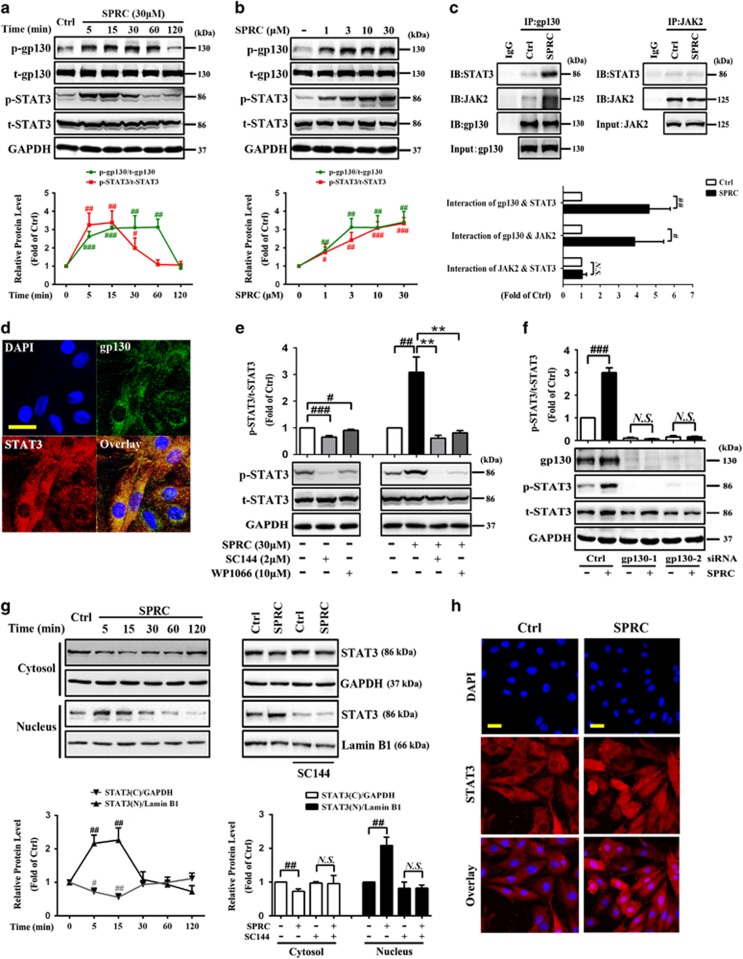
SPRC induces STAT3 phosphorylation and nuclear translocation via gp130 in cardiomyocytes. H9c2 cardiac myocytes were treated either (a) with 30 μM SPRC for the indicated durations or (b) with increasing concentrations of SPRC for 10 min. Cell lysates were collected and subjected to western blot for evaluating phospho-gp130 and phospho-STAT3. (c) H9c2 cells were treated with SPRC (30 μM) for 10 min. Cells lysates were immunoprecipitated with gp130 or JAK2 antibody, and the bound proteins were fractionated on SDS-PAGE gel, then analyzed by western blot with antibodies indicated. (d) Cells were incubated with SPRC (30 μM) for 10 min, and then double-immunostained for gp130 and STAT3 and the nuclei were visualized by DAPI staining. Scale bar, 50 μm. (e) Cells were pretreated with 2 μM SC144 (gp130 inhibitor) or 10 μM WP1066 (STAT3 inhibitor) for 1 h, followed by SPRC stimulation. (f) Cells were incubated with SPRC after gp130 silencing, which was conducted by siRNA transfection for 48 h. (g) Cells were treated with SPRC for the indicated durations, or pretreated with/without SC144 for 1 h before SPRC stimulation for 10 min. Levels of STAT3 in the cytosol and nucleus were analyzed by western blot. GAPDH and Lamin B1 were used as loading control for cytosolic and nuclear proteins, respectively. (h) STAT3 nuclear translocation after 10 min of SPRC treatment was detected by confocal microscopy. Scale bars, 50 μm. Values are presented as mean±S.D. from n=3 replicates. #P<0.05, ##P<0.01, ###P<0.001 compared with the control group; **P<0.01 compared with the SPRC-treated group. NS, nonsignificant (P>0.05)